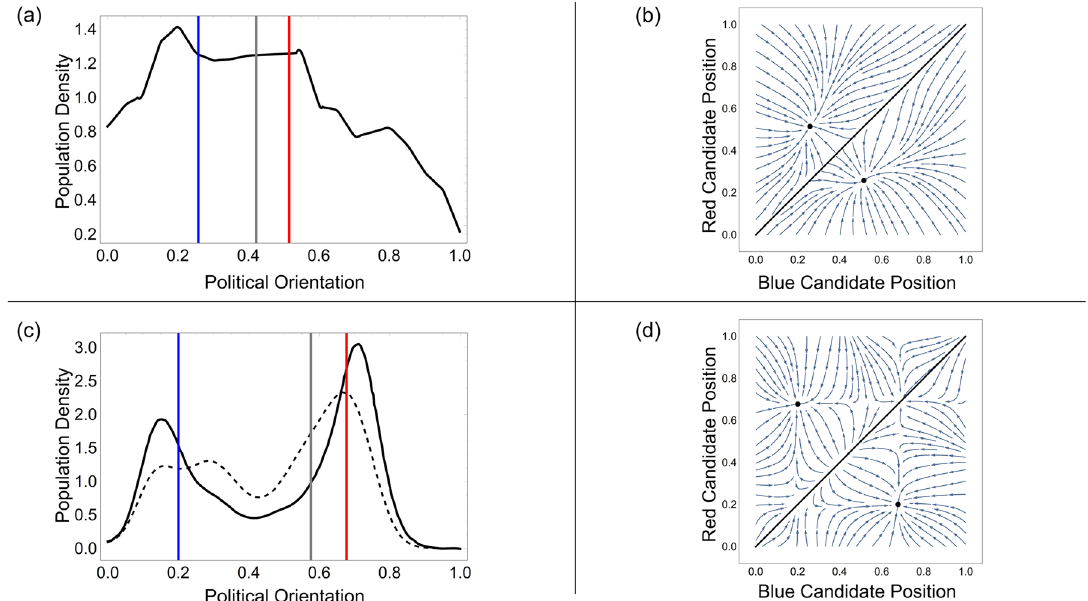
Fig. 9 Candidate optimizations based on real-world ideological distributions. Here we show the results of testing our model on real-world data. First, we used the distribution of voter ideology according to the Summer 2017 Political Landscape Survey (Pew Research Center, 2017) ( a ), and the rational candidate responses to this landscape ( b ). We also used an analysis of Twitter users (Mukerjee et al., 2020) ( c ), and the rational candidate responses to this landscape ( d ). In a and c , vertical lines show the convergent position of each candidate (blue and red) and the position of the median voter (gray). c also shows the political ideology of political leaders on twitter in dashed gray, and we see that the vertical blue and red lines match nicely with peaks for this curve. Both models used P = 2, Q = 30, and R = 1, a set of parameters that approximate the credence that an average voter may give to not voting or voting for a third party. The population in c can be fi t to a bimodal distribution. The best fi t has the left and right subpopulations ’ peaks at 0.18 and 0.70, standard deviations at 0.09 and 0.07, and relative weights at 1 and 1.32, respectively. In a , the population is less bimodal, and so the fi t has less value. However, for completeness, we give the values here: positions 0.18 and 0.37, standard deviations 0.04 and 0.41, and relative weights of 1 and